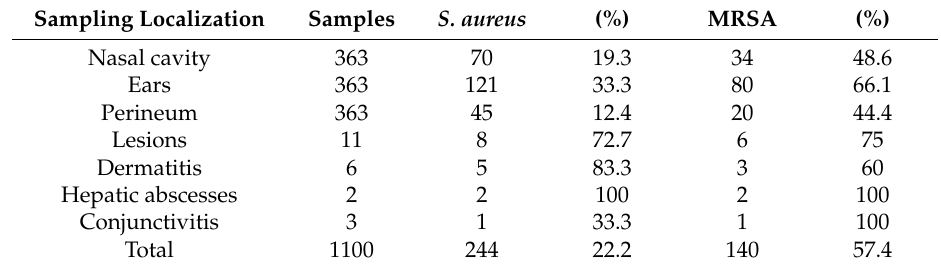
Table 3. Positive samples to S. aureus and MRSA according to sampling localization (in the di ff erent studied